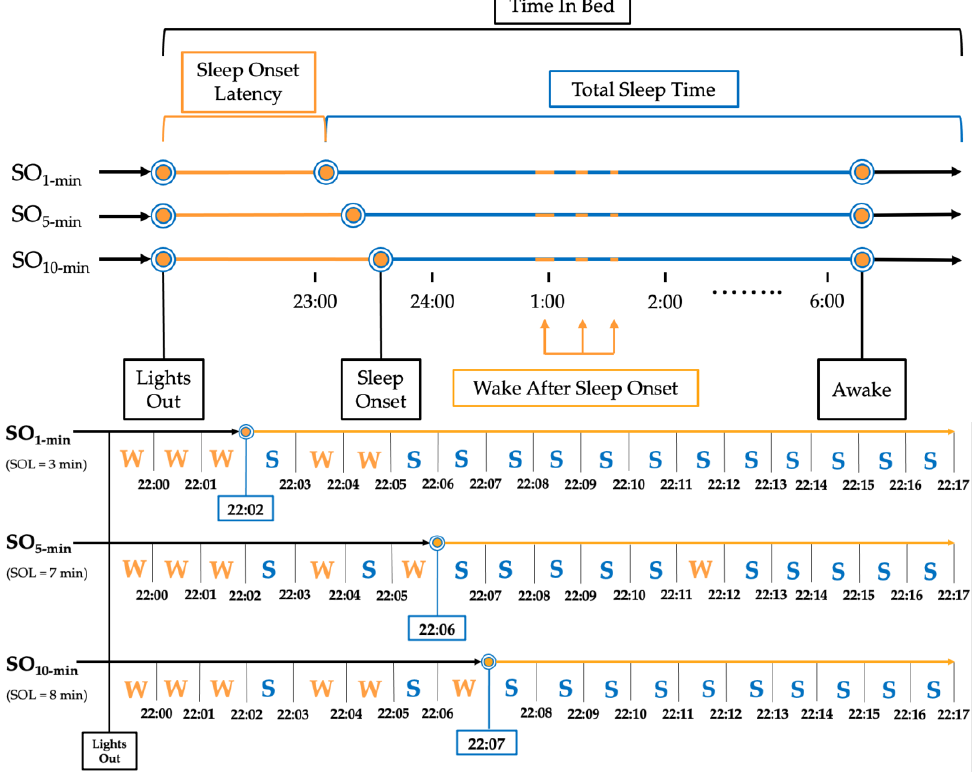
Figure 1. Example of implementation of sleep onset rules for a single participant. Note: Representa- tion of a single night processed using the three sleep onset rules for a mock participant. SO 1 min = Sleep Onset defined as first epoch scored as ‘Sleep’; SO 5 min = Sleep Onset defined as first 5 consecutive epochs scored as ‘Sleep’; SO 10 min = Sleep Onset defined as first 10 epochs scored as ‘Sleep.’.